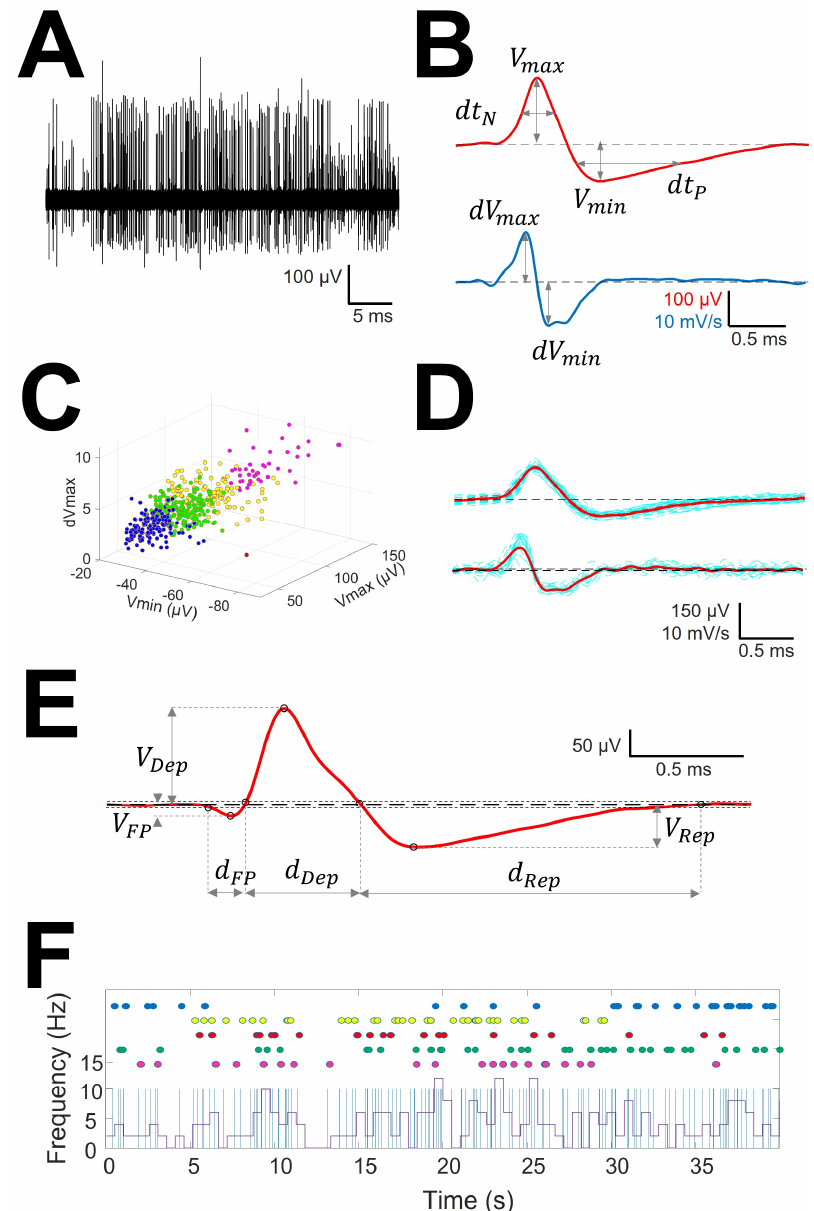
Figure 1. Sorting and analysis of AP and pattern discharge. ( A ) Raw recording showing EAP as vertical lines of different amplitude; ( B ) EAP (upper row) and first derivative (lower row) showing the definitions of variables computed for sorting; ( C ) clustering in different units (identified by different colors) of the raw trace. Only three dimensions are shown, although clusterization used up to 6. ( D ) mAP (upper row) and mean derivative of EAP (lower row) in red obtained from EAP and derivatives of EAP of similar morphology (blue lines); ( E ) Example of mAP showing the definition of variables analyzed. Tick dashed line represents basal voltage, and thin dotted lines represent upper and lower thresholds used to characterize the structure. Dots are the fiducial points used to define amplitudes and phases. ( F ) Analysis of raw trace. Upper dots in colors represent EAP grouped at the same mAP and therefore ascribed to the same cell. Superimposed are showed a binary plot (blue lines) where each line represents an EAP and a chart diagram showing the frequency measured at 1 s-bin.